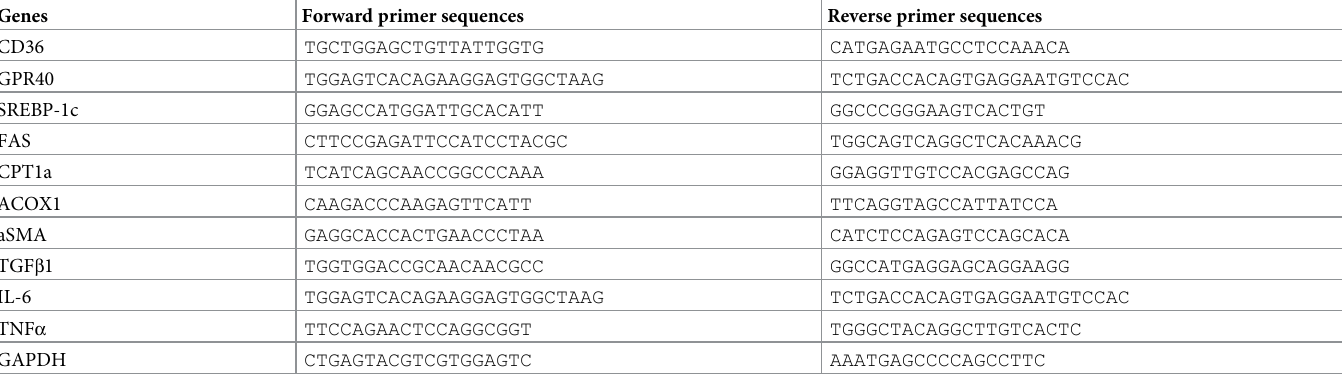
Table 1. Sequences of primers used for real-time PCR.